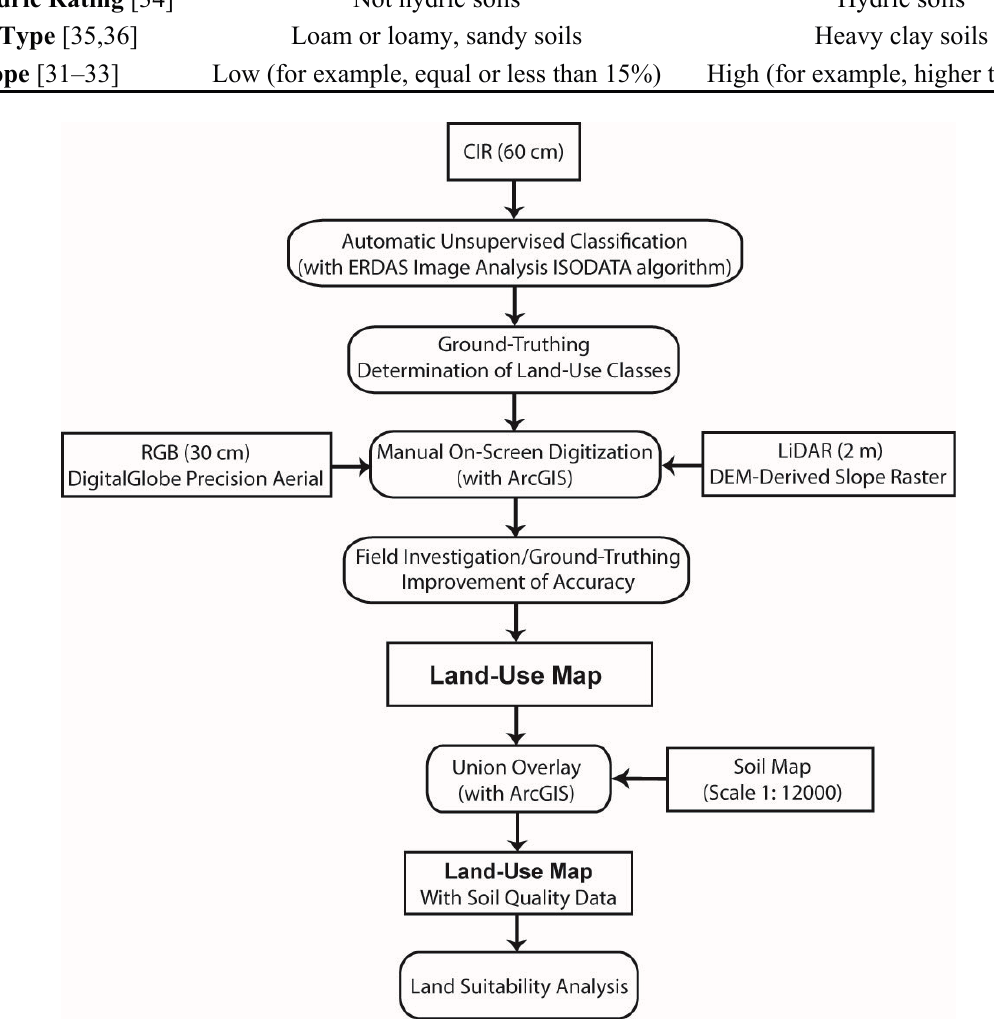
Figure 3. Flowchart showing methodological steps of the GIS mapping in this